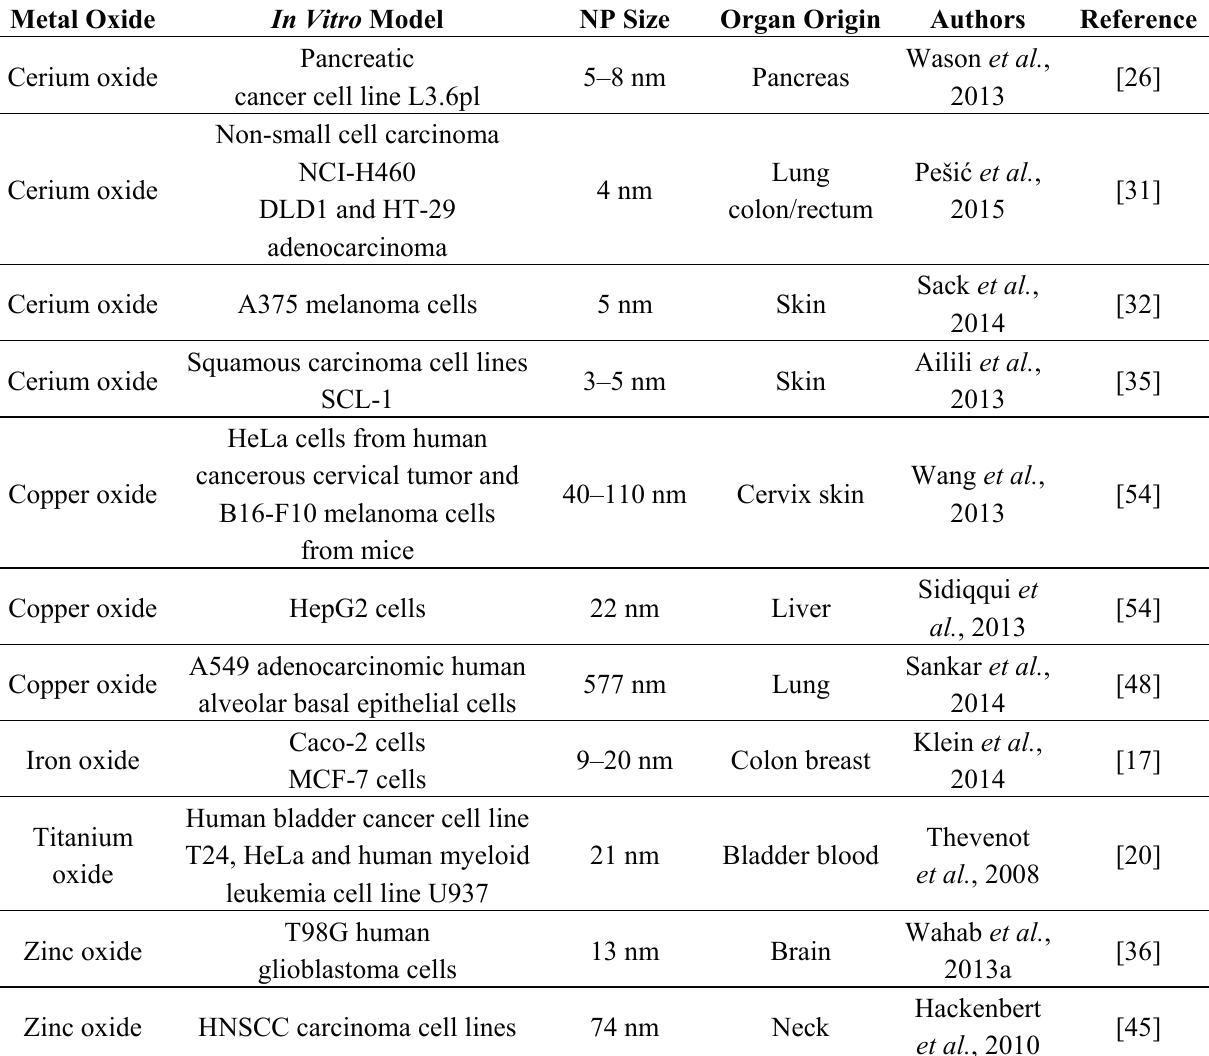
Table 2. Metal oxide NPs with anticancer activity by direct action on tumor cells in different in vitro studies. HNSCC, head and neck squamous cell